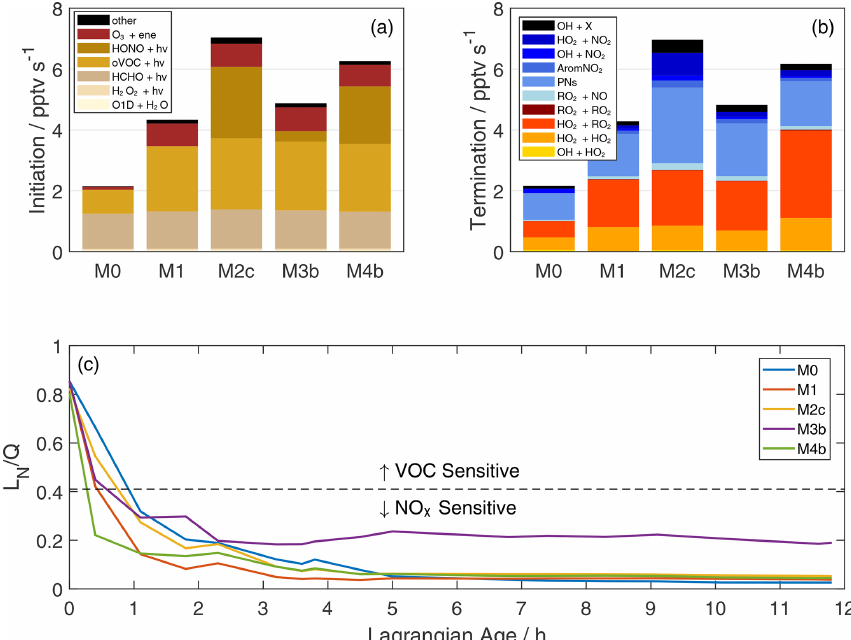
Figure 5. Rates of RO x initiation (a) and termination (b) integrated over the first five data points (Lagrangian age 0–2.3h) via trapezoidal integration. In panel (a) , oVOC + hν includes all oVOC photolysis reactions other than HCHO, and “other” includes NO 3 + VOC and other minor reactions. In panel (b) , yellow–red and blue shades represent RO x -RO x and RO x -NO x reactions, respectively. AromNO2 represents the formation of nitroaromatics, and PNs are the net formation of peroxy nitrates. OH + X (purple) represents reactions of OH with organic compounds (typically PNs), which result in formation of NO 2 and other non-RO x products. The fraction of RO x radicals lost via reactions with NO x is shown in panel (c) . Model simulations are as described in Fig. 2 and Table 1. The dashed line denotes the approximate transition between NO x -sensitive and VOC-sensitive ozone production for biomass burning chemistry, as suggested by Robinson et al.